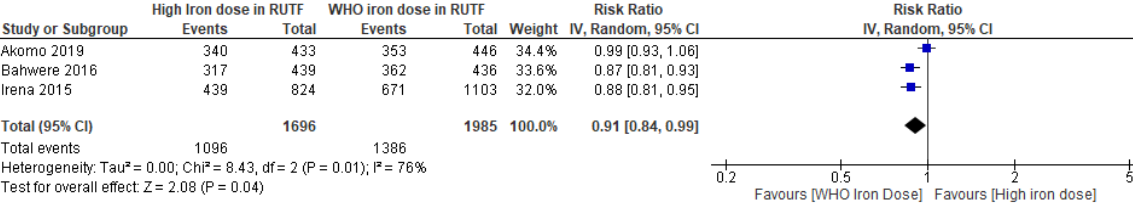
Table 5. Description of side-effect profiles in the included studies.